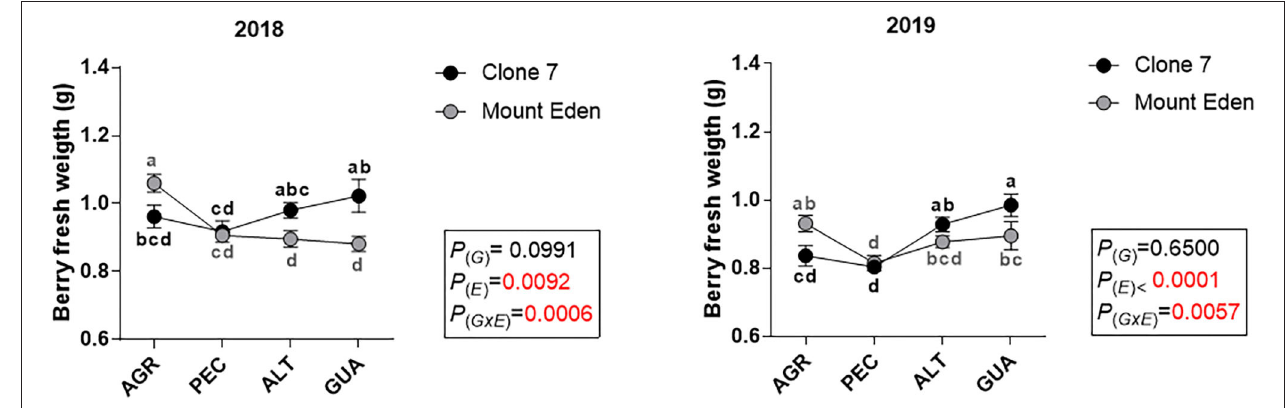
FIGURE 5 | PCA of non-anthocyanin compounds in Cabernet Sauvignon Clone 7 (C7) and Mount Eden (ME) wines, from vineyards in AGR, PEC, ALT and